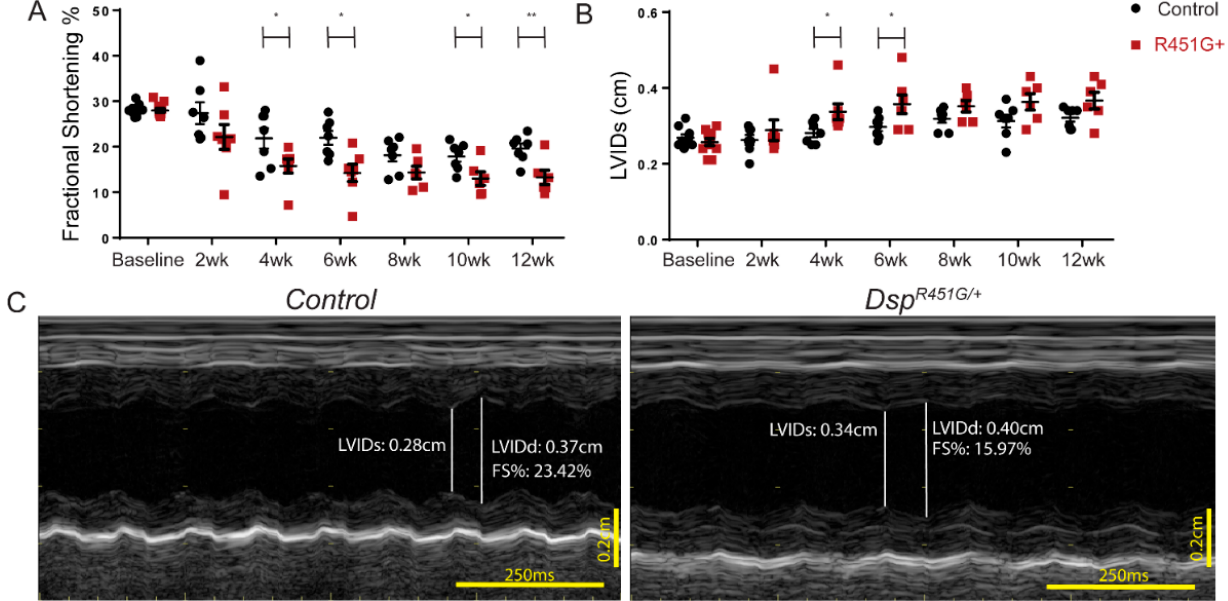
Figure 4. Dsp R451G/+ mice display structural changes post-TAC surgery. ( A ) Comparison of fractional shortening ( B ) and LVIDs between Dsp R451G/+ mice and control littermates post-TAC surgery. Meas- urements taken every 2 weeks after surgery (control n = 7, Dsp R451G/+ n = 6–7 post-surgery). Stats performed using Student’s t -test within each timepoint * p < 0.05, ** p < 0.01. ( C ) Representative M- mode echocardiography recordings from Dsp R451G/+ and control littermates 4 weeks post-TAC sur-